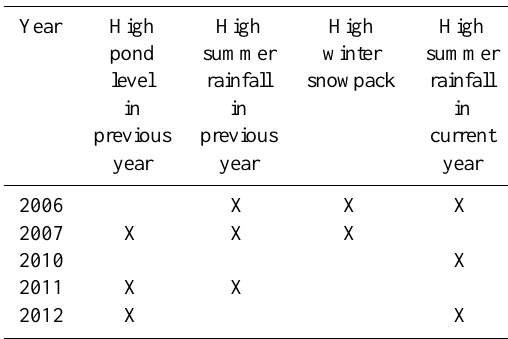
Table 2. Factors influencing the pond levels during wet